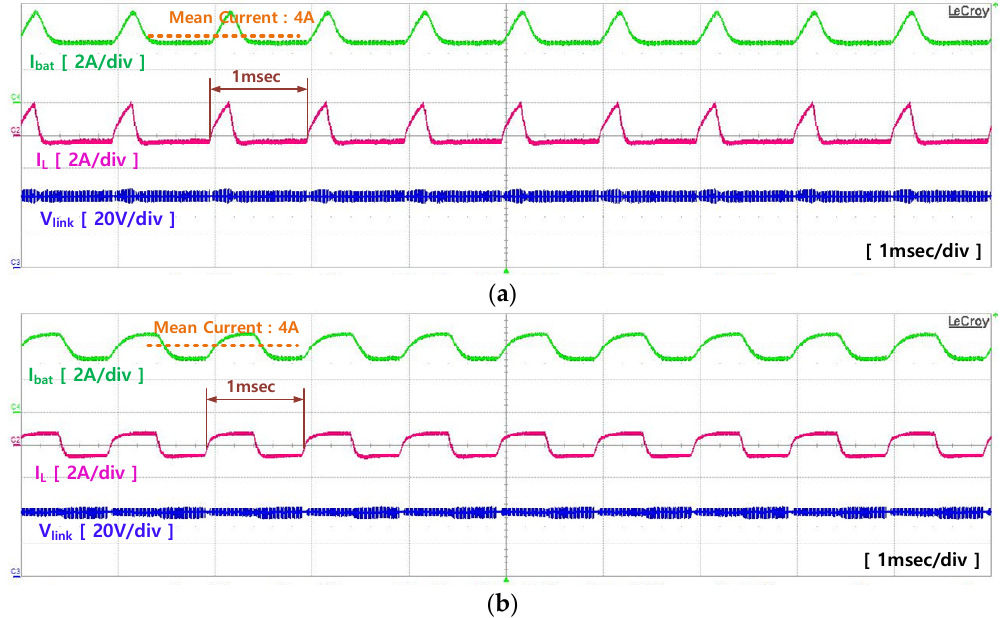
Figure 14. Characteristics of the steady state: ( a ) pulse duty: 20% and ( b ) pulse duty: 50%.